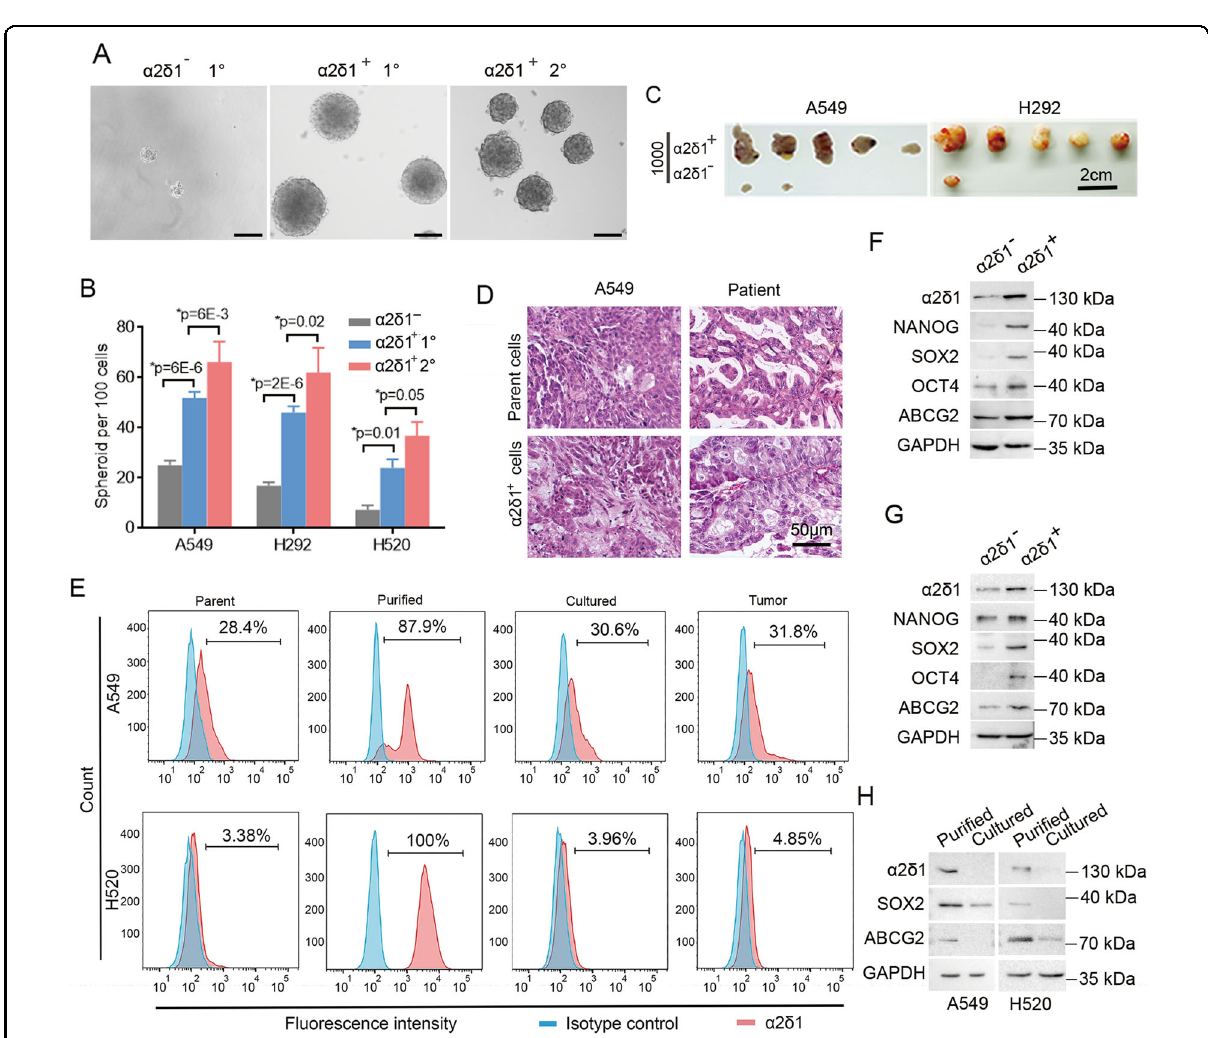
Fig. 2 The stem cell-like properties of α 2 δ 1 + NSCLC cells. A Representative phase-contrast photographs showing the primary (1°) and serially passaged (2°) spheroids formed by indicated subpopulations sorted from H520 cell line by FACS. Scale bars, 100 µm. B Histograms show the primary (1°) and serially passaged (2°) spheroid formation ef fi ciencies of the α 2 δ 1 + cells as compared with α 2 δ 1 – cells sorted from indicated sources. Data are presented as the mean ± SD of three independent experiments ( n = 3). *Student ’ s t -test. C Photographs of dissected tumors formed by sorted α 2 δ 1 + and α 2 δ 1 – cells from indicated sources ( n = 5). D The histology of the tumors formed by α 2 δ 1 + cells sorted from the A549 cell line and the primary tumor of one NSCLC patient was compared with that of the parent A549 tumor and the original patient tumor, respectively, by H.E. staining. E Flow cytometry analysis of the percentage of α 2 δ 1 + fractions in parental cells (Parent), freshly FACS-puri fi ed α 2 δ 1 + subpopulations (Puri fi ed) and puri fi ed α 2 δ 1 + cells cultured in 10% FBS for 2 weeks (Cultured) or engrafted into NOD/SCID mice (Tumor). F – H The expression of the indicated molecules